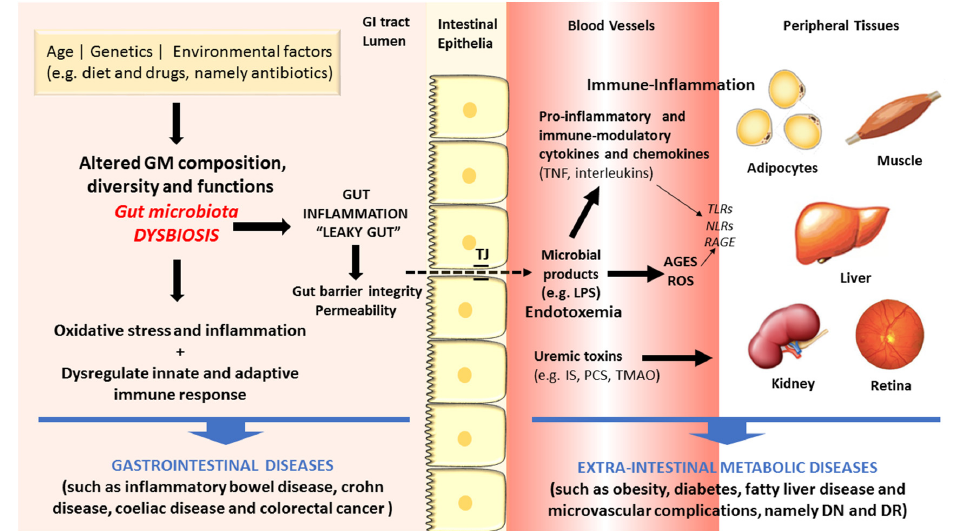
Figure 2. Schematic diagram of some of the main factors and pathways linking dysbiosis to gastrointestinal and extra-intestinal metabolic and vascular diseases.